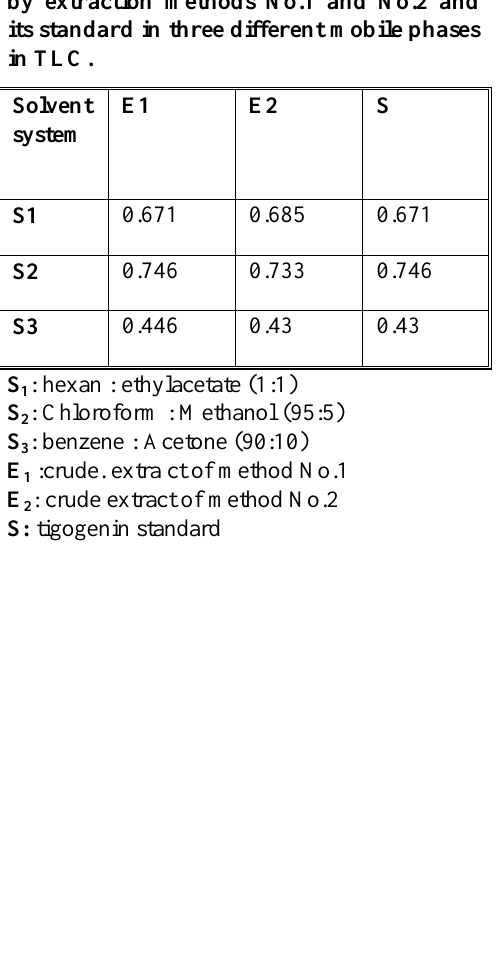
Table(2): Rf values of Tigogenin from Agave americana L . leaves extract